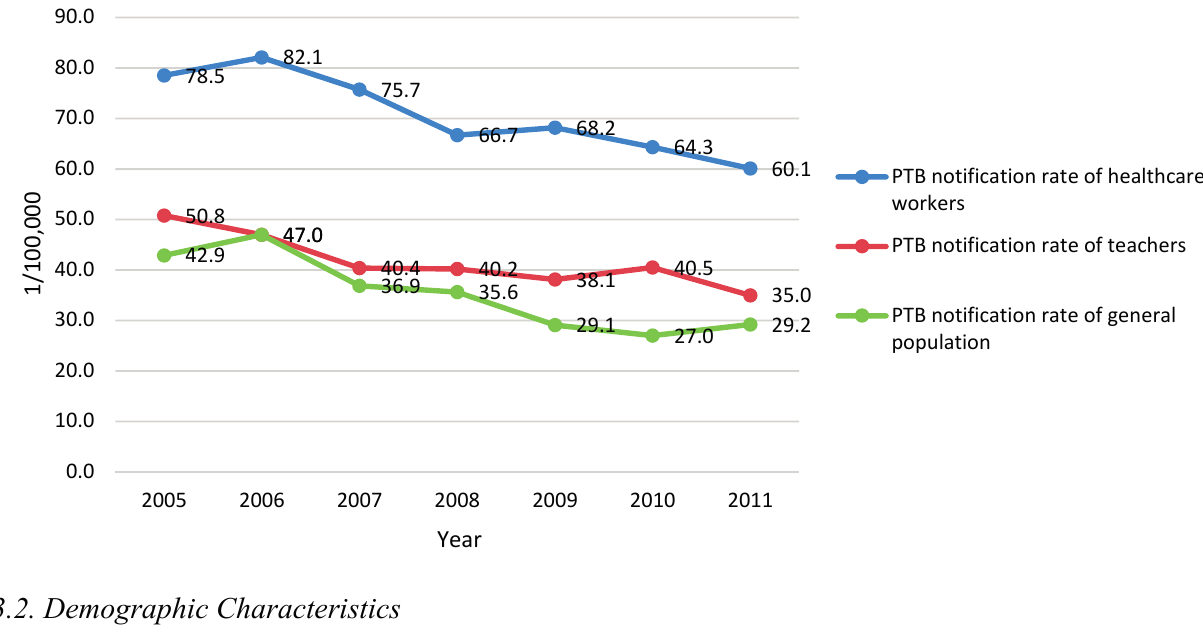
Figure 2. PTB notification rate of the general population, HCWs, and teachers from 2005 to 2011 in Zhejiang Province, China